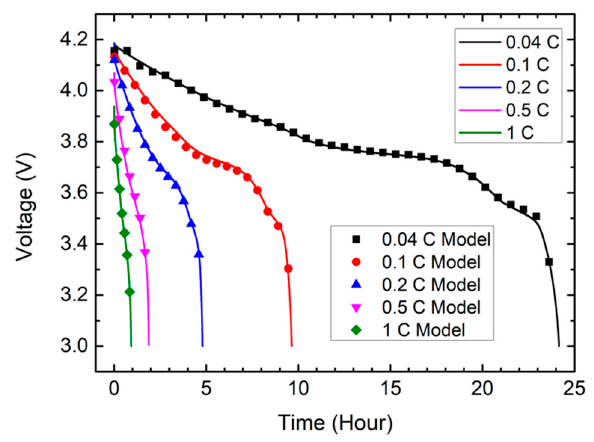
Figure 15. Curve of P brand 18650, Epoch = 100, look_back = 10.